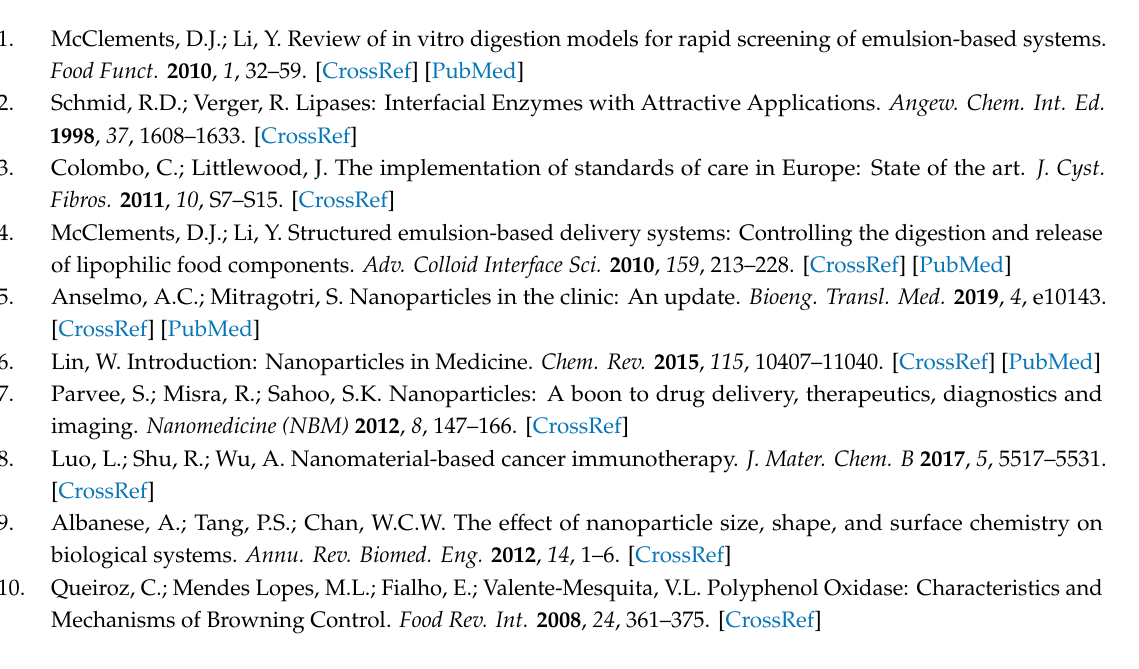
Table S1: Lipase activity for the tested materials in presence and absence of tauro deoxycholate (NaTC). Author Contributions: Conceptualization, P.A., A.A. and J.V.R.-L; investigation, S.M.-P., J.E.H., J.V.R.-L.; data curation, S.M.-P., P.A., J.E.H., A.A. and J.V.R.-L.; writing, P.A., A.A. and J.V.R.-L.; funding acquisition J.V.R.-L. All authors have read and agreed to the published version of the